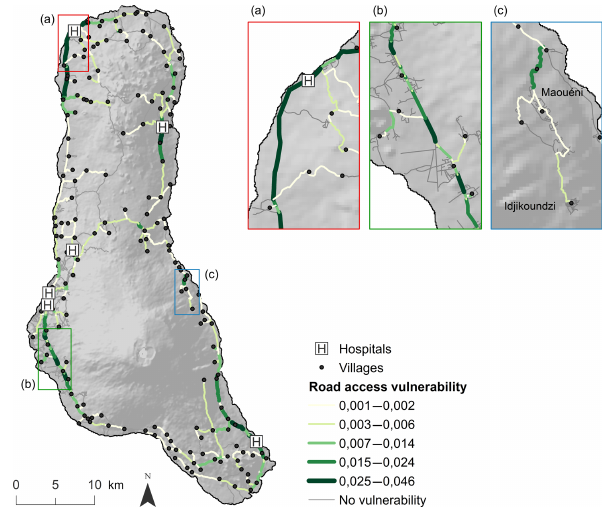
Figure 6. Road access vulnerability map representing the impact of each road segment obstruction on the population’s accessibility to the closest infrastructure in terms of travel